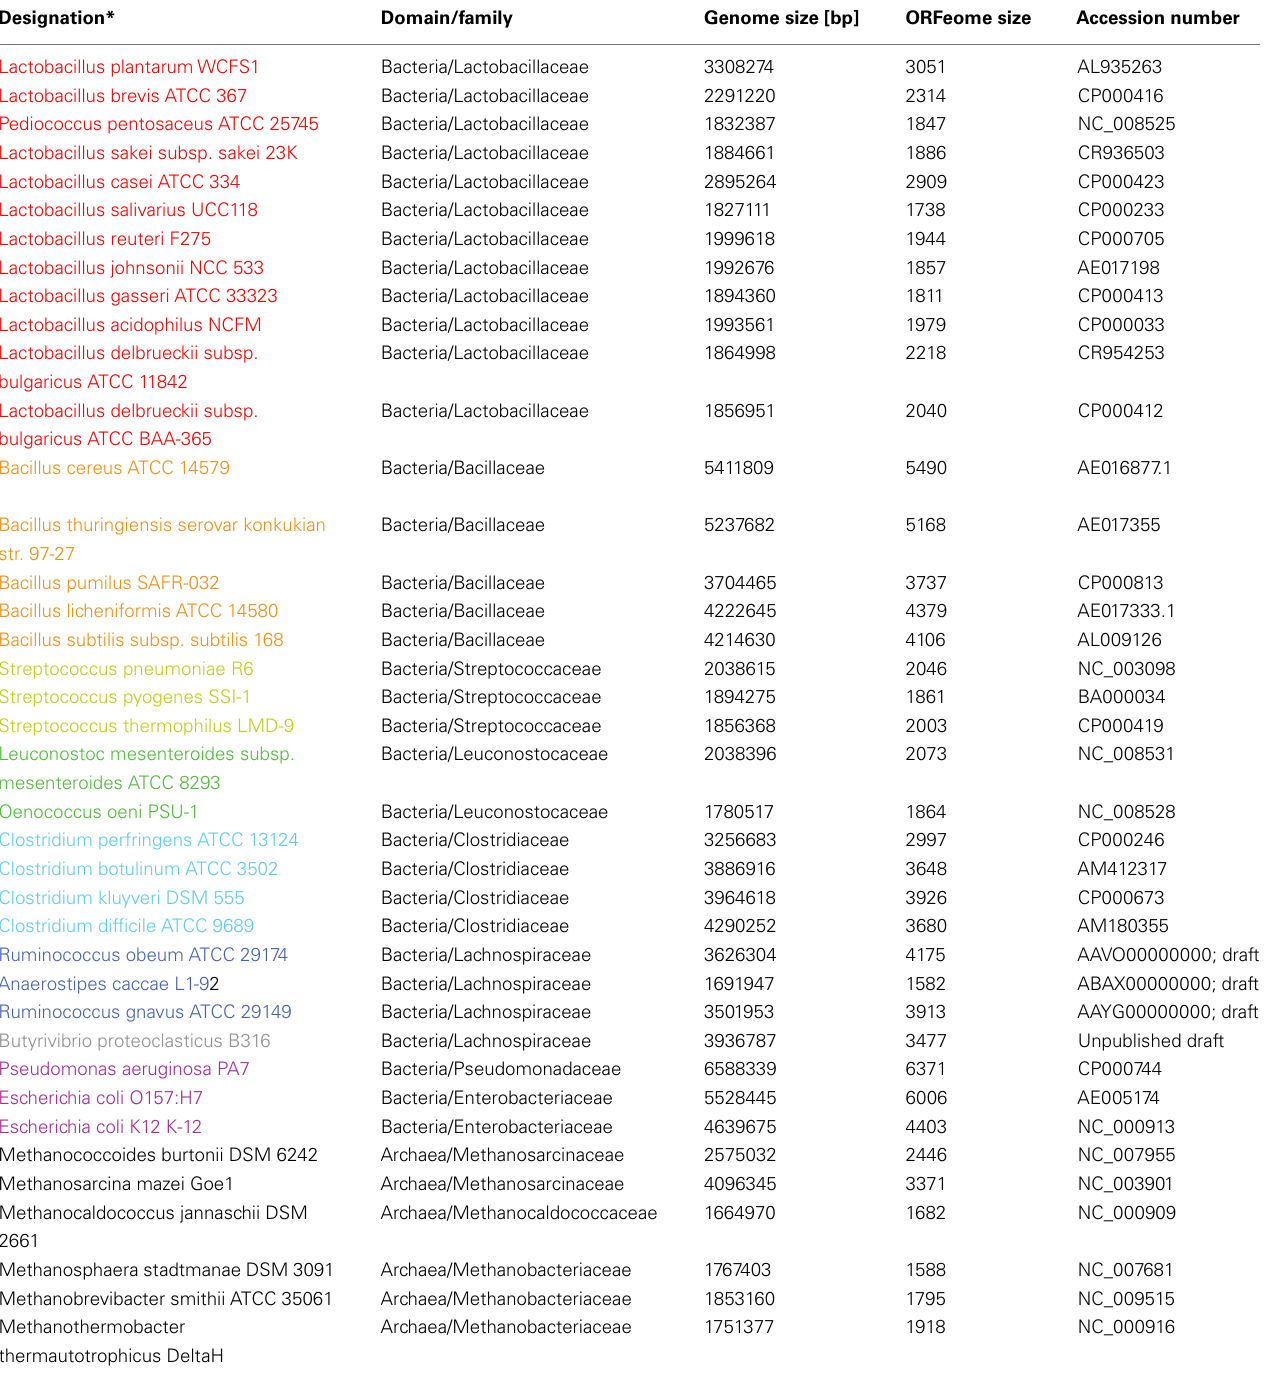
TableA2 | Genomes used for assessment of functional genome distribution.